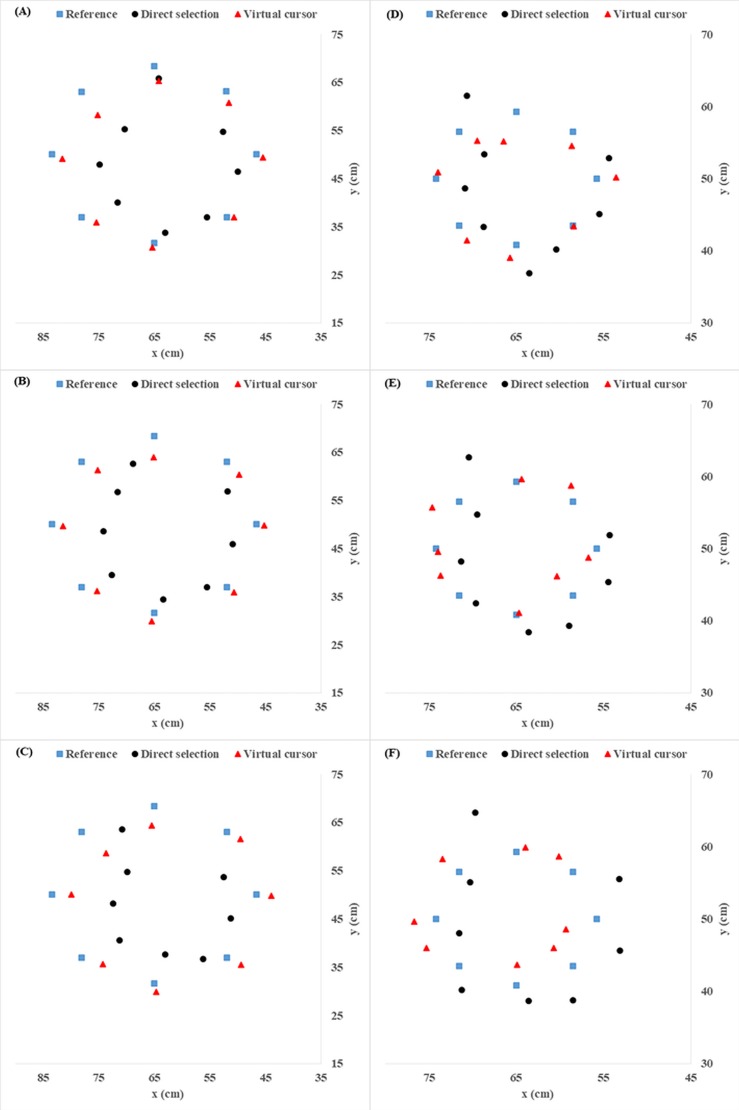
The overall mean of pointing estimations with respect to reference targets in direct selection and virtual cursor conditions at 36 cm of c2c distance for (A) 3.7 cm target size, (B) 1.5 cm target size, and (C) 0.6 cm target size. The figure also compares the overall mean of estimates of pointing with respect to a reference target at 18 cm of c2c distance, for (D) 3.7 cm target size, (E) 1.5 cm target size, and (F) 0.6 cm target size.